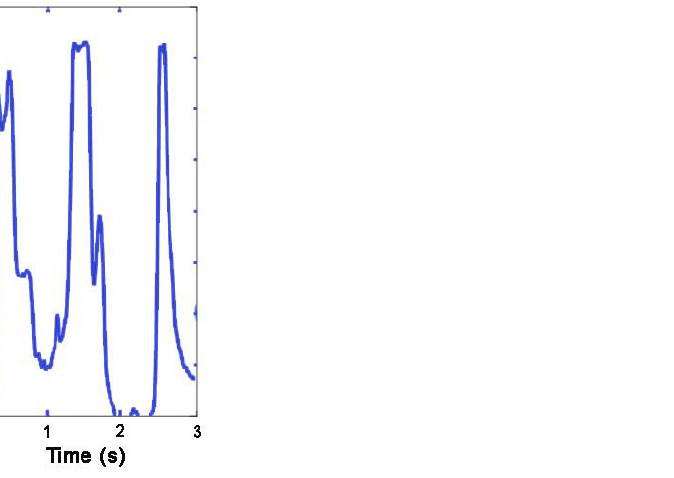
Figure 3. Example of a trace in which the maximal value of the sensor was exceeded for the two spikes on the right.